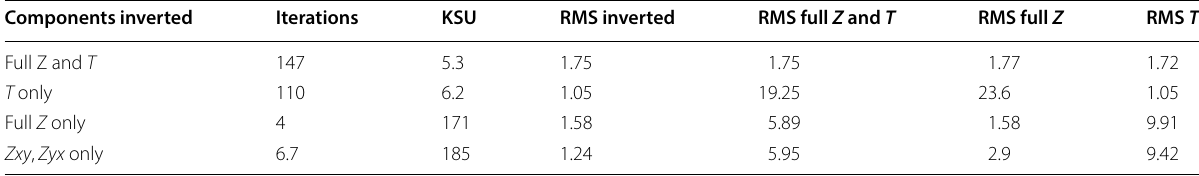
The final RMS is given for the components that were inverted (column 3). The RMS is also given for a forward calculated model for the full impedance tensor and tipper, and the RMS for this overall (column 4) and the individual Z (column 5) and T (column 6) are also given